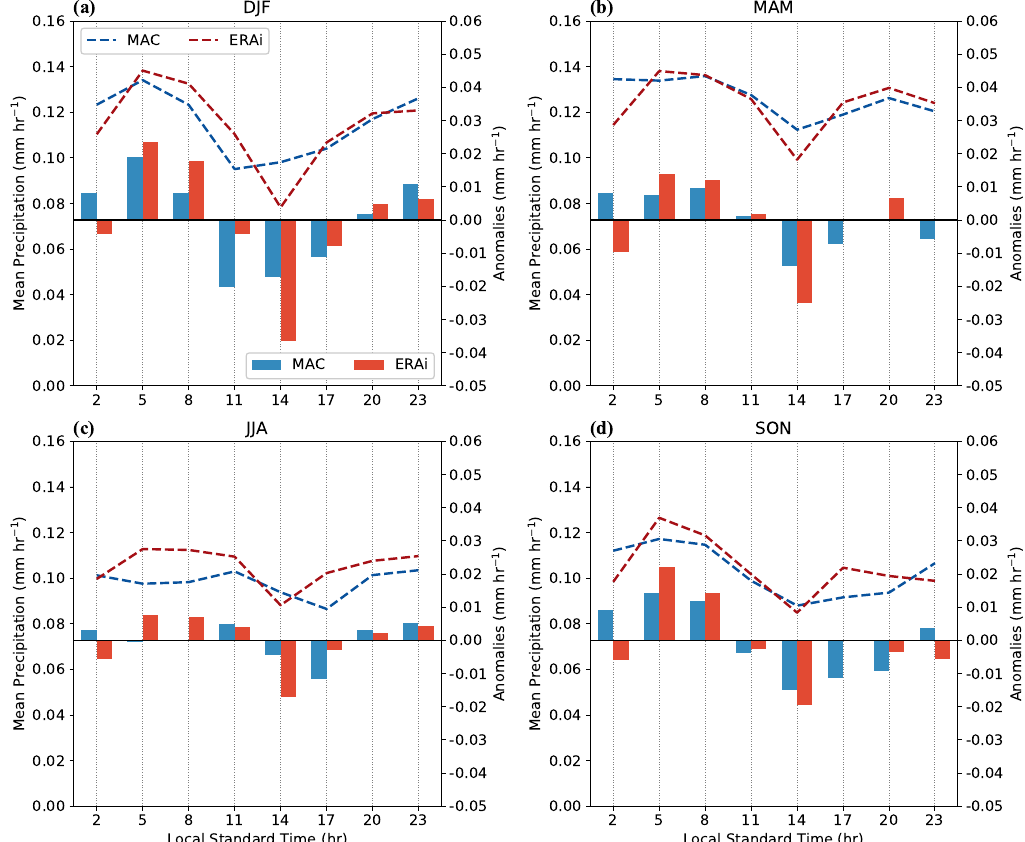
Figure 4. Mean diurnal cycle of precipitation (left axes, dashed lines) and anomalies (right axes, bars) for both MAC observations and ERA-Interim dataset, for total precipitation during ( a ) summer (DJF), ( b ) autumn (MAM), ( c ) winter (JJA), and ( d ) spring